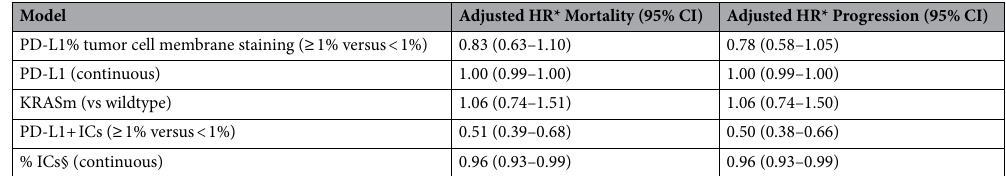
Table 2. Hazard ratio (HR) and associated 95% confidence interval (95% CI) of mortality and progression (defined as time to next treatment) according to PD-L1 expression, and KRAS mutation status among stage III unresected NSCLC patients diagnosed 2000–2013 and registered in the Danish Lung Cancer Group clinical database^ *Adjusted for age, sex, histology (adenocarcinoma versus other), Charlson comorbidity index score and age of the tumor specimen. § % ICs: % tumor infiltrating immune cells. ^NSCLC: non-small cell